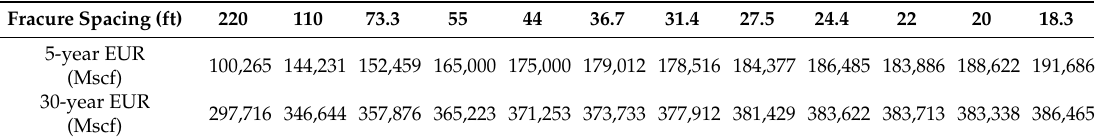
Table 3. Variation of 5-year and 30-year EURs (Mscf) when producing with well spacing varying between 200 and 1500 ft, as forecasted by the ResFrac integrated simulator.